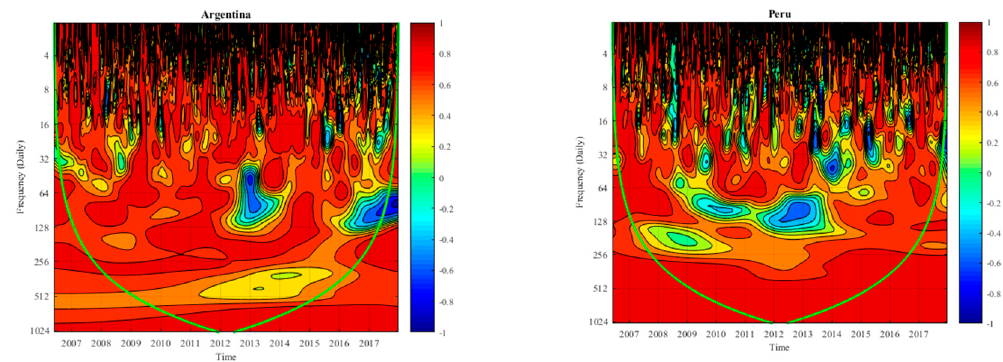
Figure 3. The America region’s Islamic-conventional stock returns wavelet correlations.